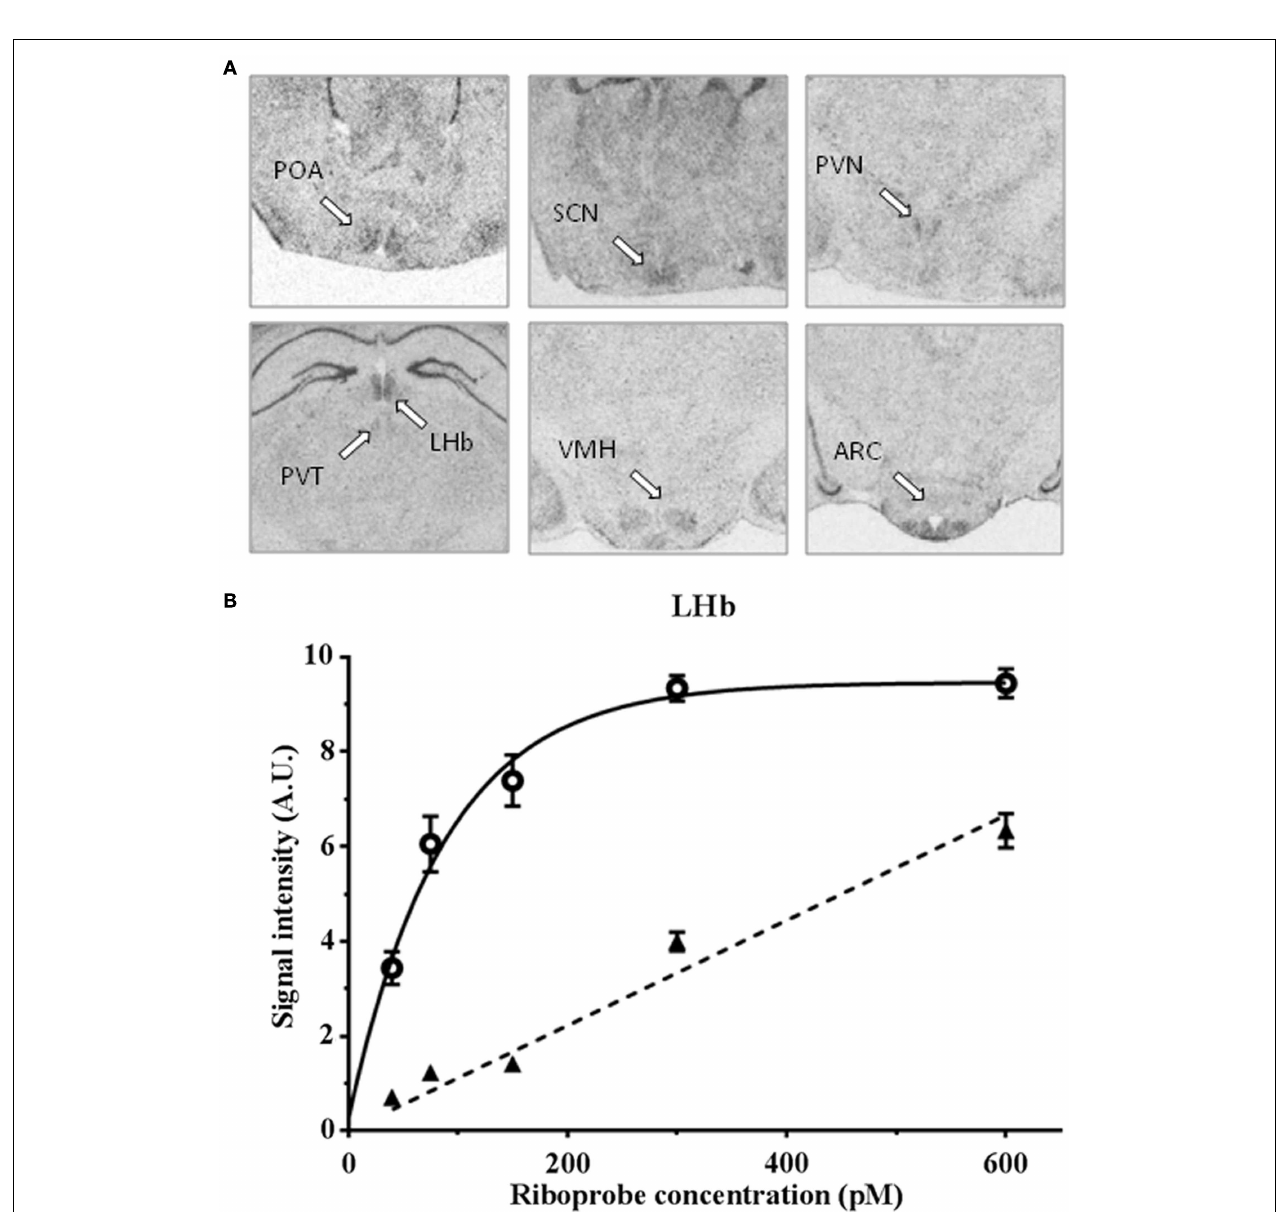
(VMH), and arcuate nucleus (ARC) of Syrian hamster brain sections, bar = 2mm; (B) specific (full line) and non-specific (dotted line) hybridization signal with a 35 S-labeled antisense Kiss1r cRNA riboprobe in Syrian hamster lateral habenular